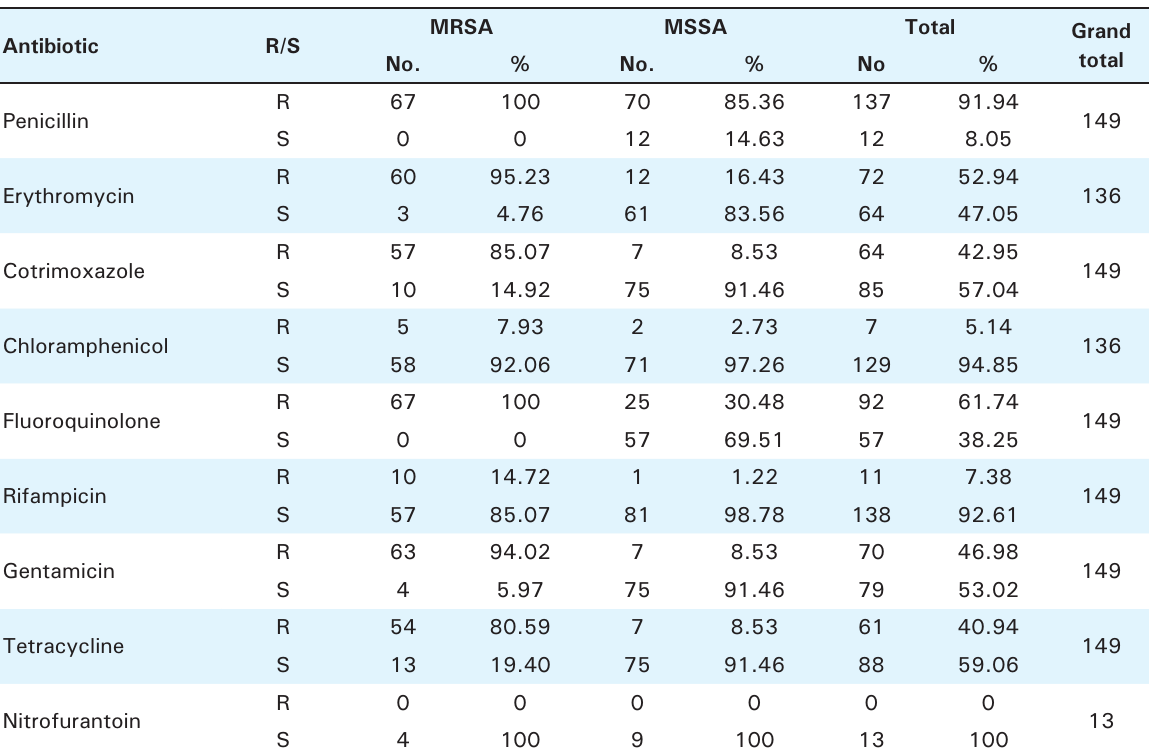
Table 1. Susceptibility of isolates to different antibiotics Antibiotic R/S